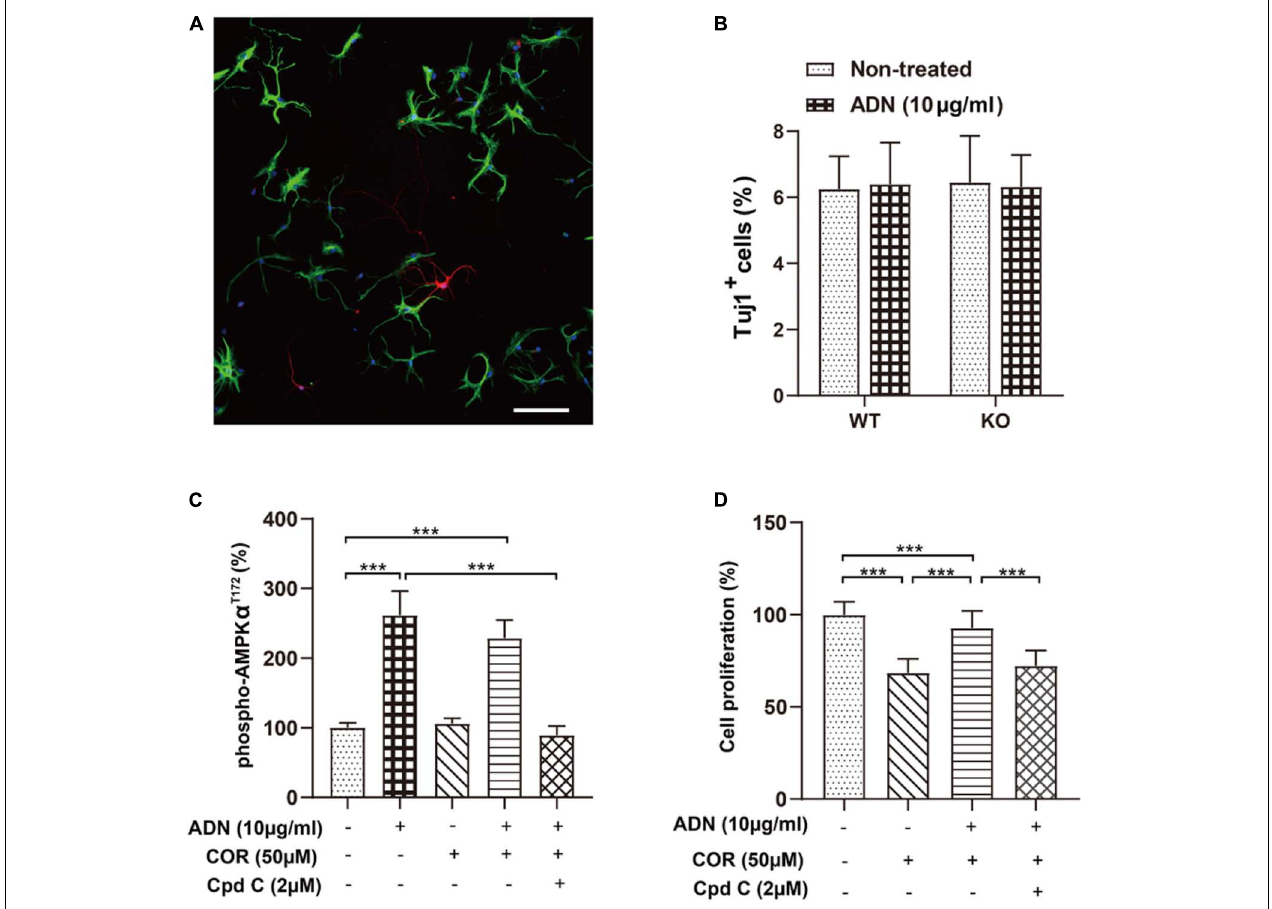
FIGURE 5 | Inhibition of the AMPK pathway diminishes adiponectin-enhanced cell proliferation in vitro. (A) The representative image showing that NPCs grown on coverslips after a 6-day culture in the induction medium differentiated into the Tuj1 + neuronal cells (red) and the GFAP + glial cells (green) with the corresponding diverse morphologies. Scale bar: 100 µ m. (B) Adding ADN into the medium to a final concentration of 10 µ g/ml did not affect the percentage of induced neuronal cells in either WT or KO NPCs; the basal neuronal differentiation was unaltered after ADN KO. N = 6 coverslips/group from 3 independent experiments. (C) The phosphorylation of AMPK at the T172 site after application of ADN, COR and Cpd C. COR did not affect the level of phospho-AMPK T172 , whereas Cpd C essentially abolished adiponectin-induced enhancement of AMPK phosphorylation. N = 4 independent experiments. (D) Cell proliferation following ADN, COR, and Cpd C treatments. Administration of COR significantly impaired neuronal proliferation which could be reversed by adiponectin addition, whereas inhibition of AMPK phosphorylation by Cpd C potently abolished the aforementioned proliferating effect of adiponectin. N = 3 independent experiments. Data are shown as means ± SD. *** p < 0.001 by one-way ANOVA and Tukey’s post hoc test. Tuj1, Neuronal Class III β -Tubulin (neuronal marker); GFAP, glial fibrillary acidic protein (glial marker); COR, corticosterone; ADN, adiponectin; Cpd C, Compound C (AMPK